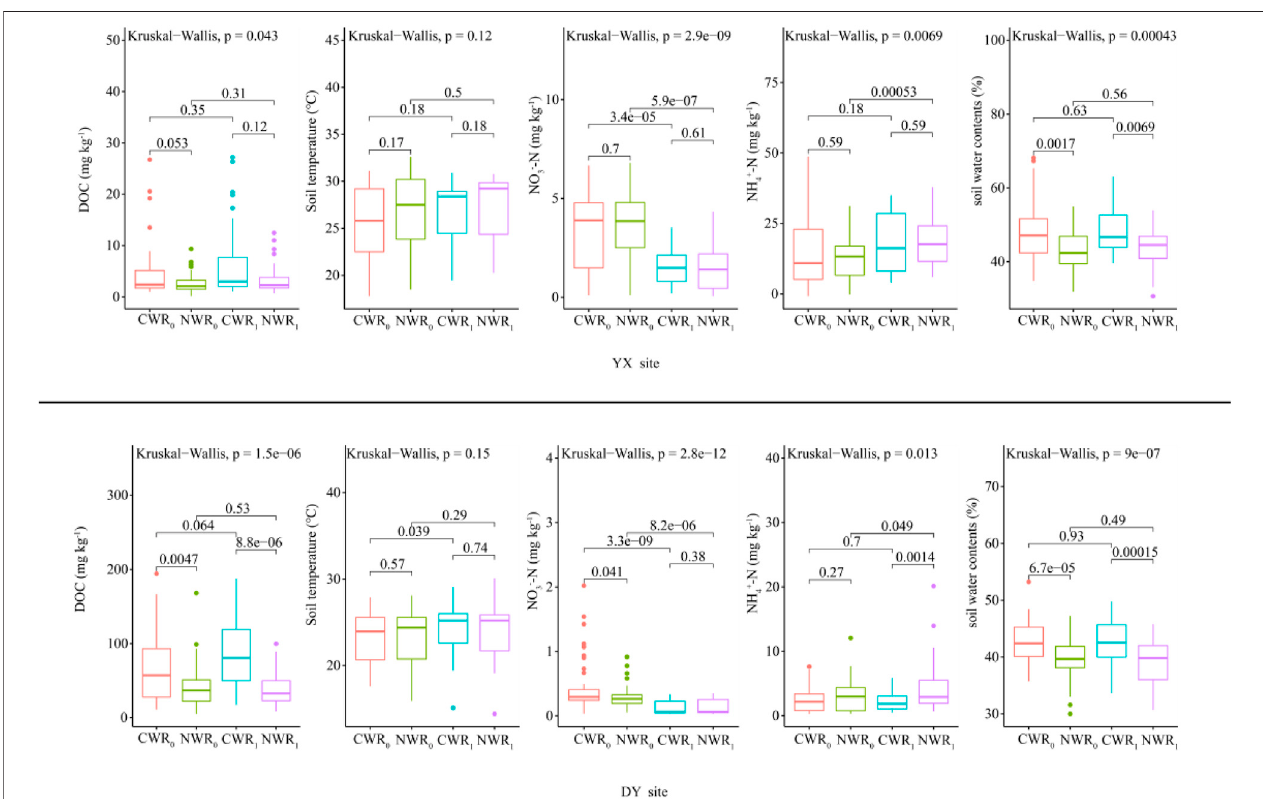
FIGURE 1 | The difference of environmental factors between YX site and DY site (adapted from Xu et al., 2020). Note: CWR 0 and CWR 1 are cold-waterlogged paddy fi eldwithoutandwithriceplanting,respectively;NWR 0 andNWR 1 arenormalpaddy fi eldwithoutandwithriceplanting,respectively.Thenumberonthehorizontal line indicates the signi fi cance of the difference. The points outside the box plot indicate